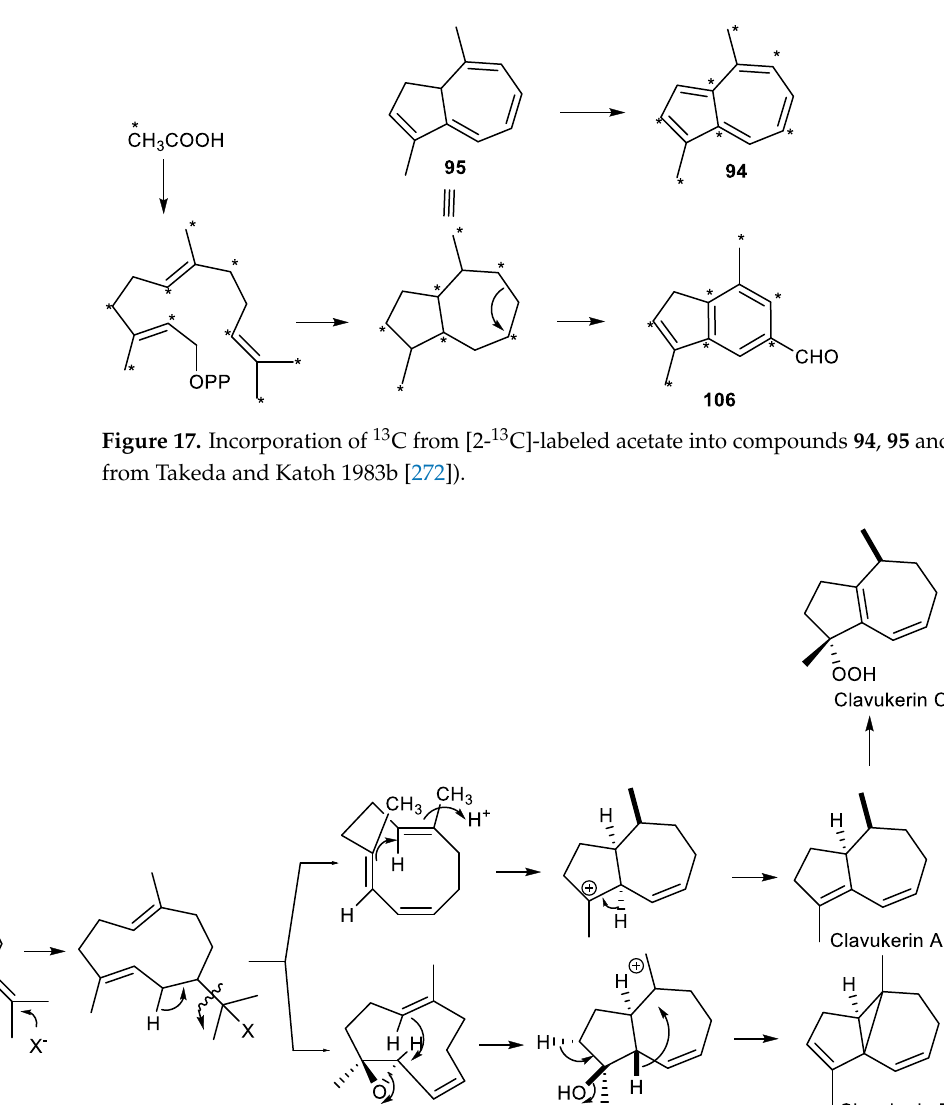
Figure 18. Hypothetical biogenetic pathway to clavukerins (adapted from Kobayashi et al. 1984b [241]).